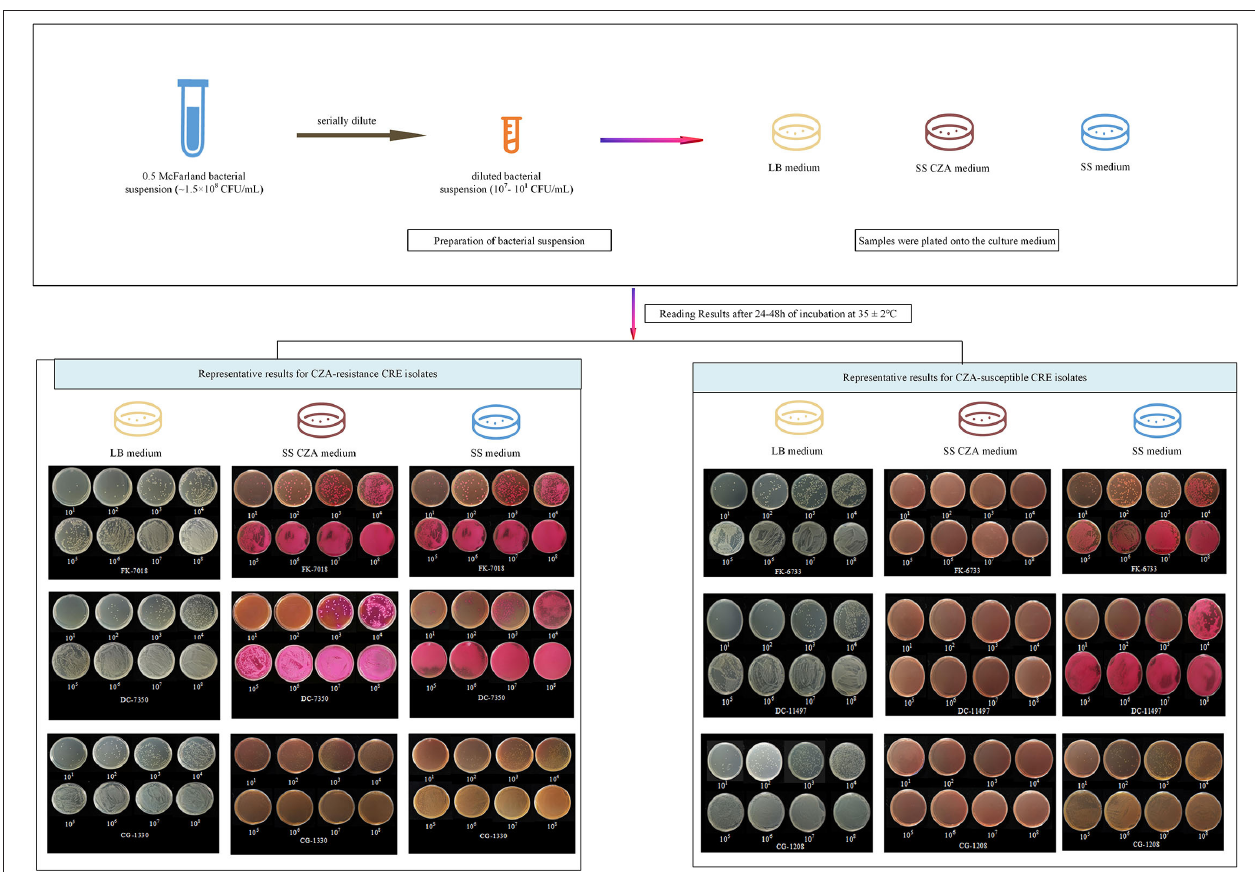
FIGURE 1 | Screening procedure and representative results with the SS CZA medium, SS medium, and LB medium. For the preparation of bacterial suspensions, 0.85% of sterile saline solution was used to adjust the bacterial suspensions to 0.5 McFarland ( ∼ 1.5 × 10 8 CFU/ml), followed by serial dilution of the bacterial suspensions with 0.85% sterile saline solution or the prepared stool suspensions to 10 7 , 10 6 , 10 5 , 10 4 , 10 3 , 10 2 , and 10 1 CFU/ml. Then, 100 µ l of each diluted bacterial suspension was plated onto the LB medium, SS CZA medium, and SS medium. All tested plates were incubated overnight at 37 ◦ C for 24–48h, after which the bacterial colonies were counted. We presented two representative results for CZA-resistant and -susceptible CRE isolates. For CZA-resistant CRE isolates (FK-7018, DC-7350, and CG-1330), they could be recovered within 24h on SS CZA medium, SS medium, and LB medium plates by using an inoculum of 10 1 -10 8 CFU/ml. In contrast, growth of the CZA-susceptible CRE isolates (FK-6733, DC-11497, and CG-1208) was inhibited within 24h on SS CZA medium plates, not on SS medium or LB medium plates, when an inoculum of 10 1 -10 8